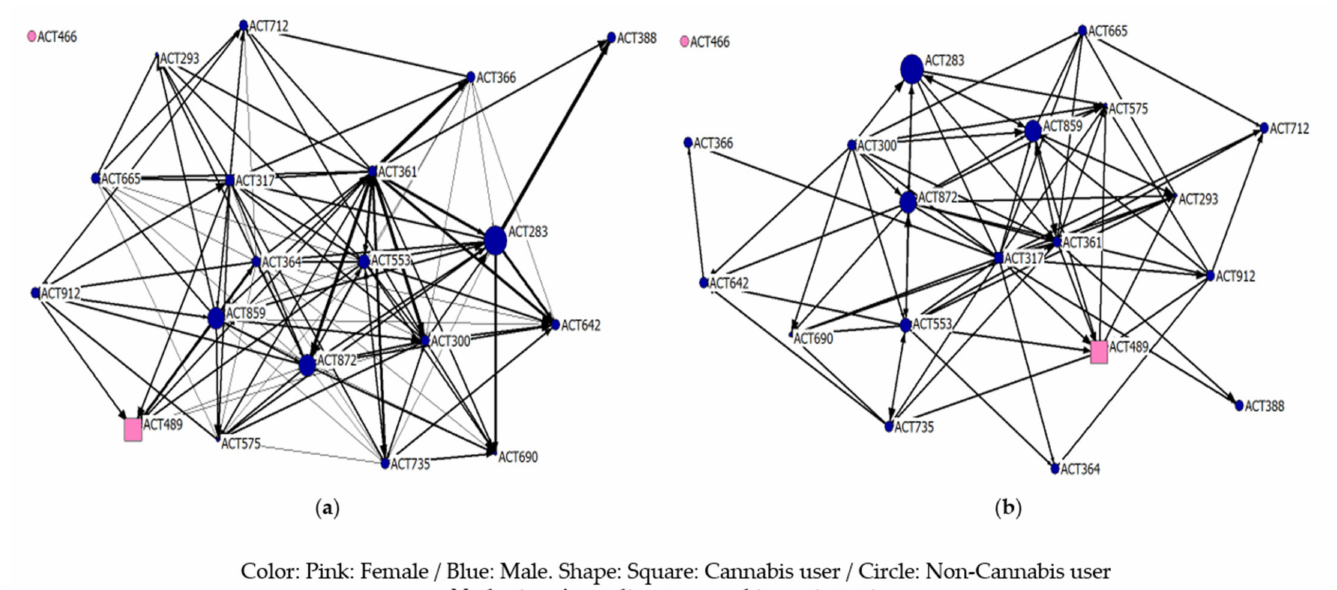
Figure 4. Cannabis use intention ( a ) consumption network; ( b ) friendship